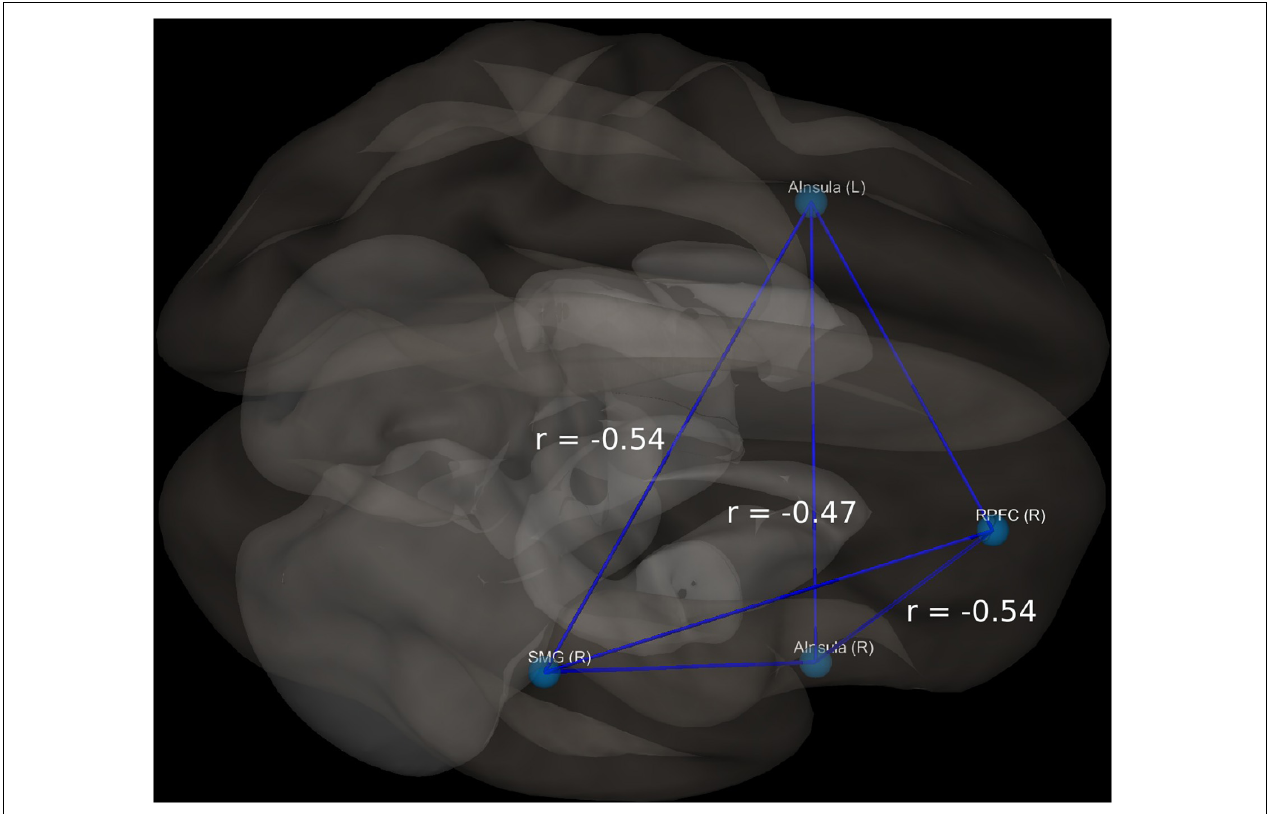
FIGURE 3 | Visualization of significant differences in FC between patients and controls; r, correlation coefficient between selected structures and SBQ-R